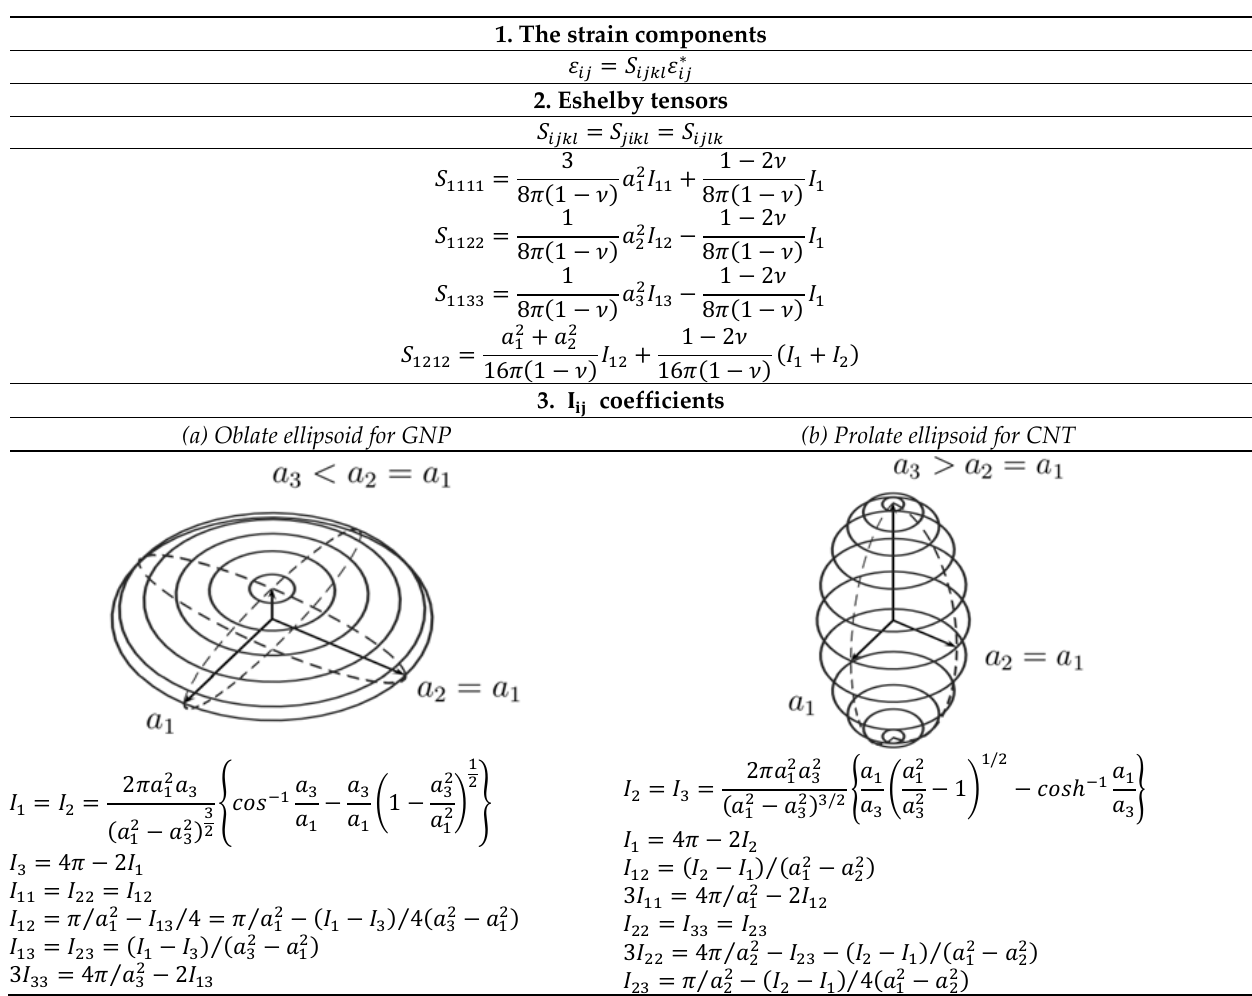
Figure 2. Eshelby tensor calculation flowchart.